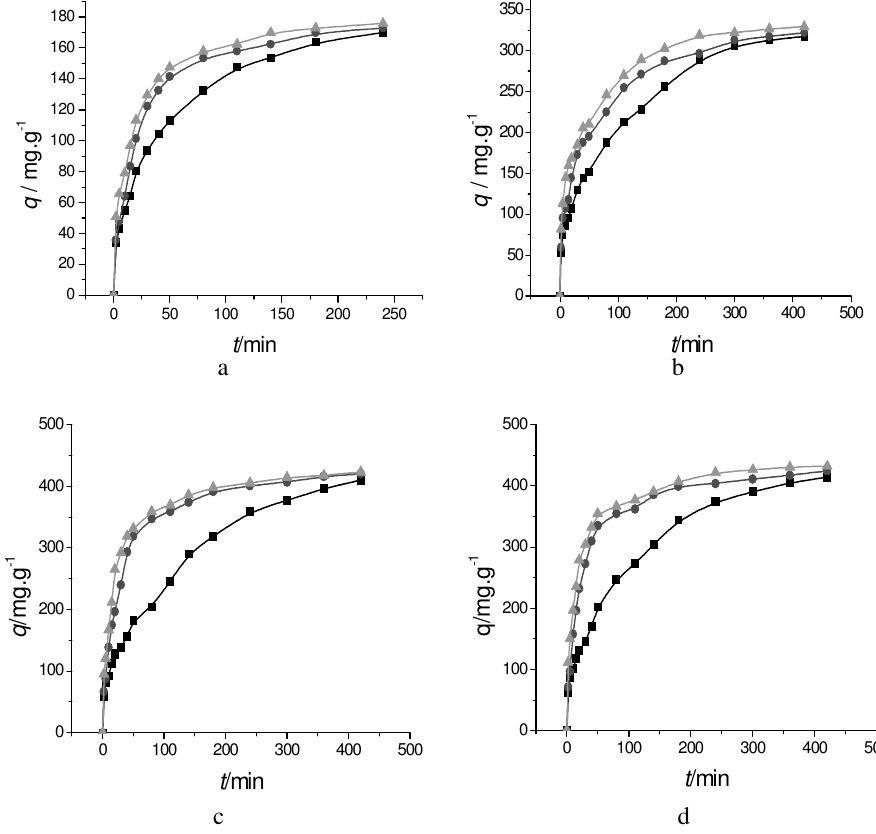
Figure 1. Influence of initial acid red 3B concentration and temperature on adsorption kinetics. Initial acid red 3B concentration is (a) 200 mg/L (b) 400 mg/L (c) 600 mg/L (d) 800 mg/L ( ■ )5°C ( ● )25°C ( ▲